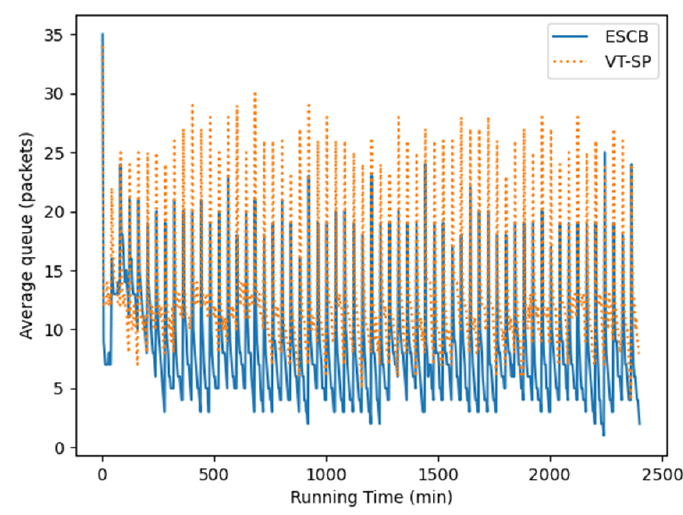
Figure 13. Average queue packets. Energy sensitive properties are reflected in the residual energy performance, as shown in Figure 14. Under high traffic density l = 30, the residual energy remains above 33%. The results indicate that the specific routing scheme largely improve the limited energy.